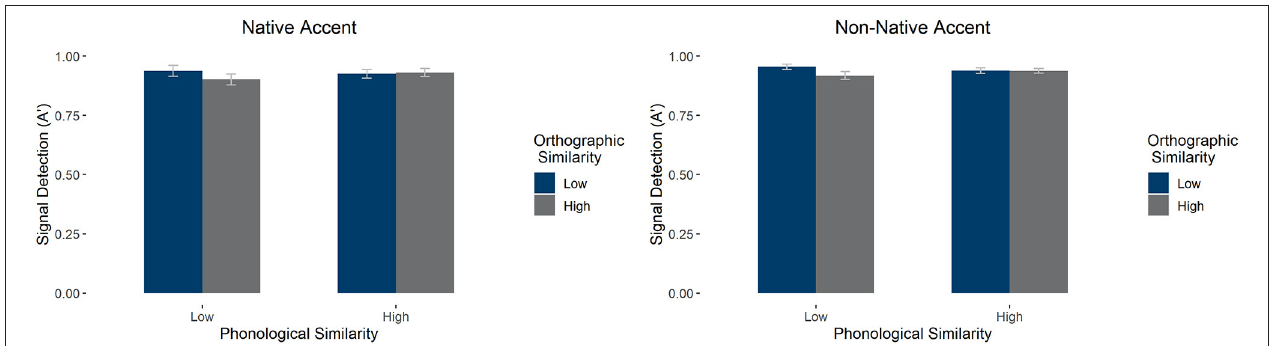
FIGURE 3 | Average signal detection (as measured by A’) in the LDT by accent, orthographic similarity, and phonological similarity condition. Error bars mark 95% confidence intervals.